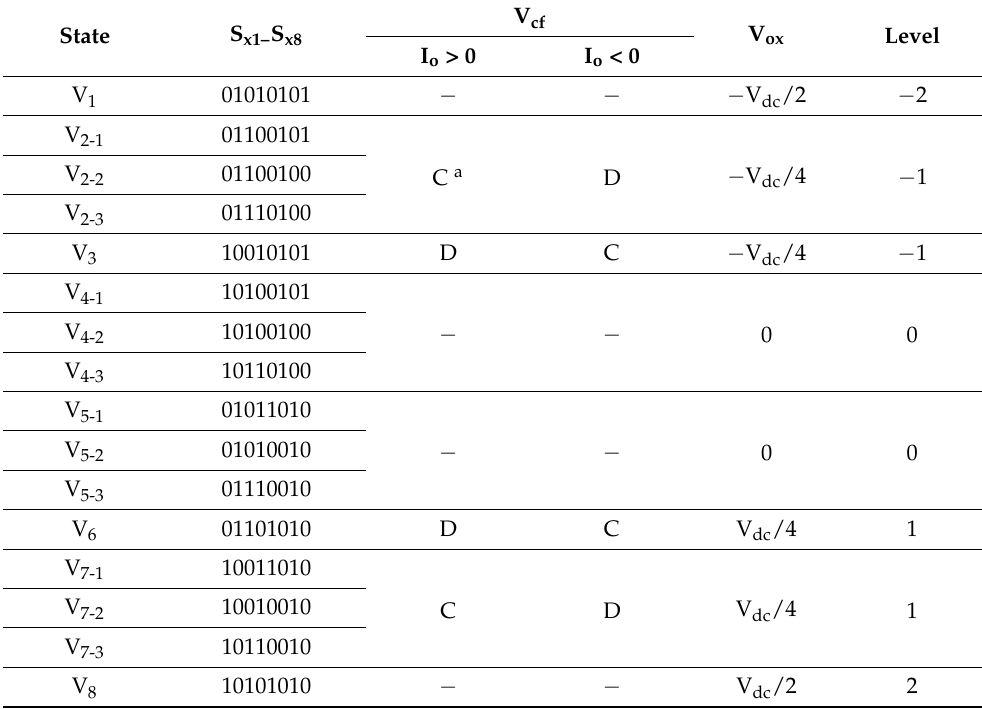
Table 2. The ANPC-5L converter’s switching states and influence on the voltage of the flying capacitors.